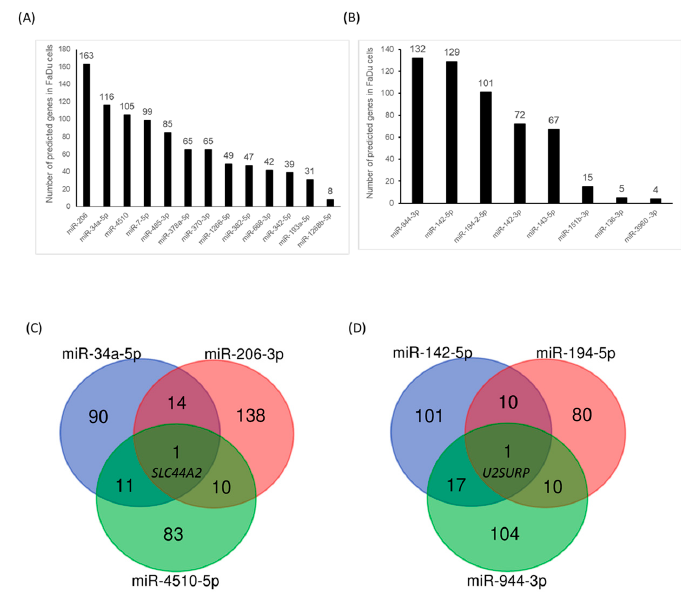
Figure 5. Analysis of miRNA-target interactions. ( A ) The individual target number of microRNAs up-regulated by 188 Re-liposome. ( B ) The individual target number of microRNAs down-regulated by 188 Re-liposome. ( C , D ) The Venn diagram calculated and drawn by the three microRNAs with the most targets.